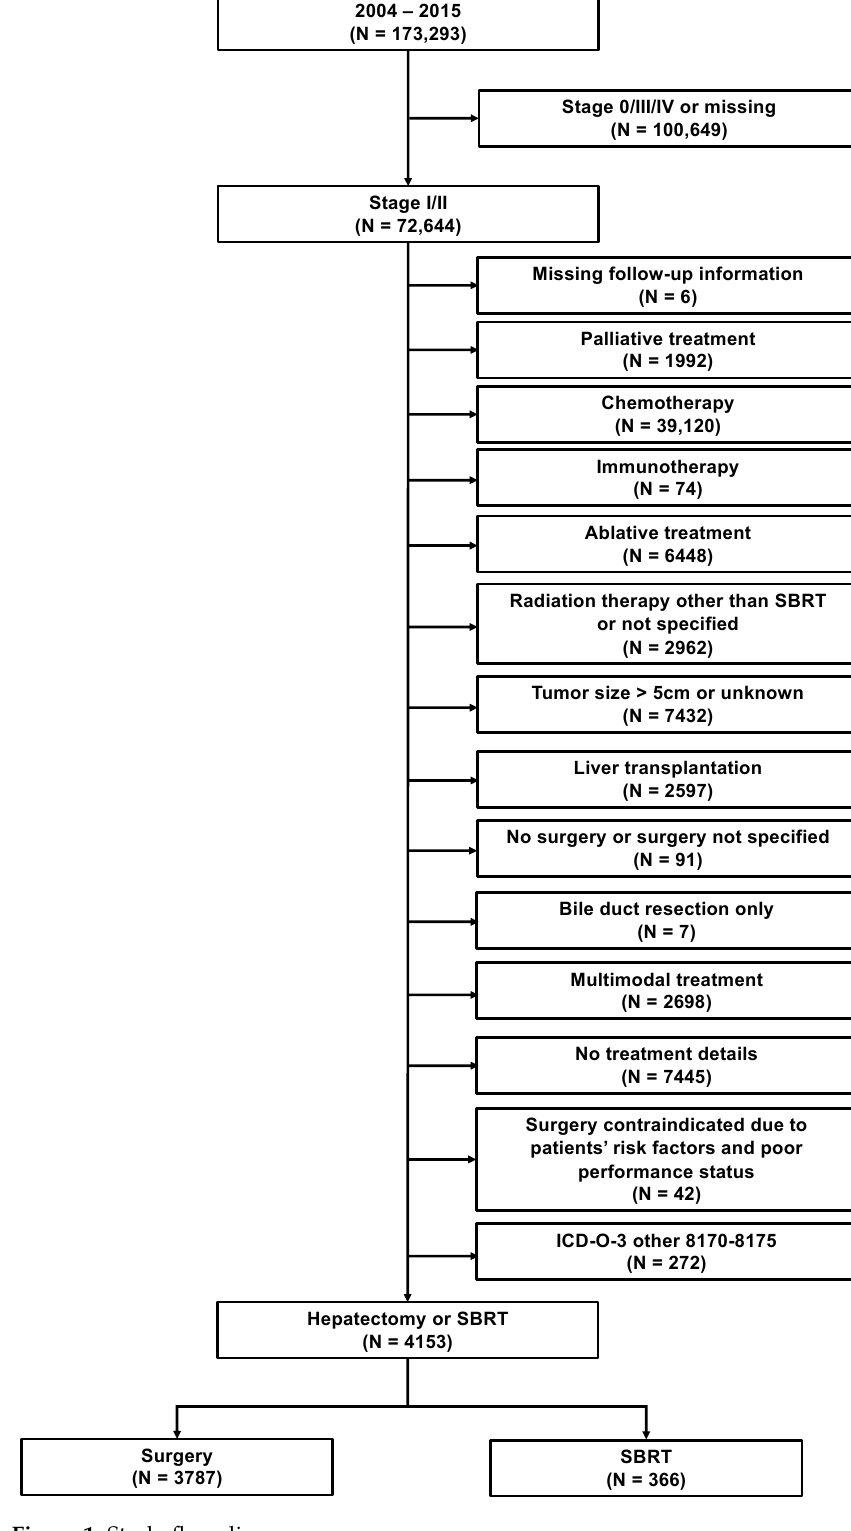
Figure 1. Study flow Figure 1. Study fl ow diagram. The extracted clinicopathologic variables included age, sex, race, year of diagnosis, treating facility, the distance between residence and facility, educational a tt ainment (high